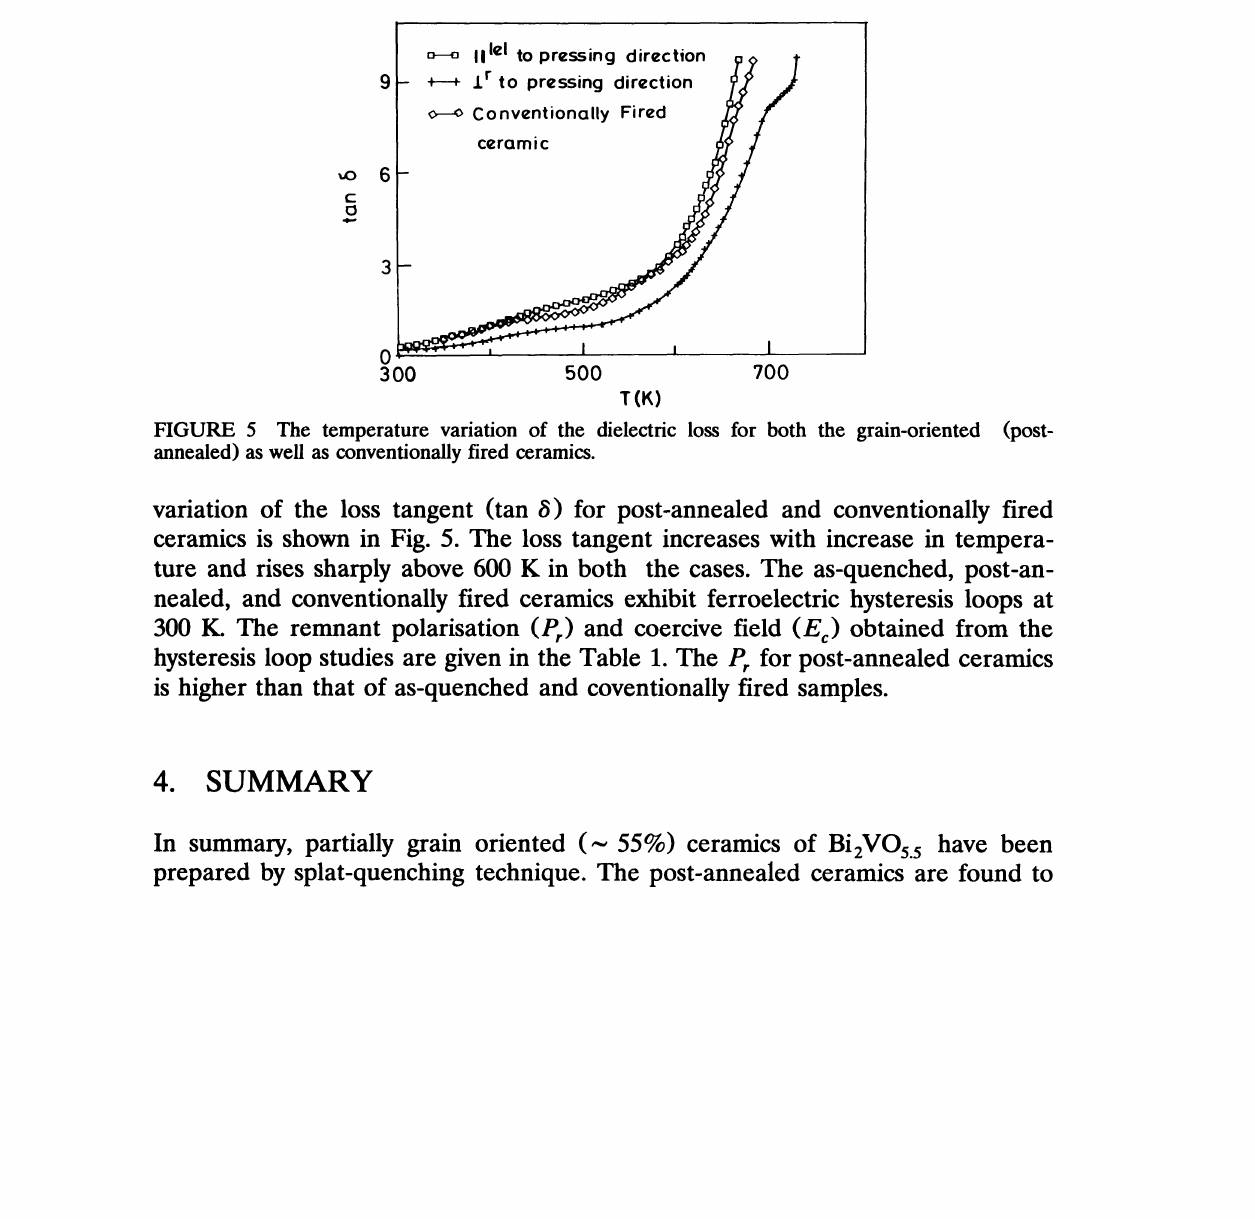
FIGURE 4 The temperature variation of the dielectric constant for both the grain-oriented (post- annealed) as well as conventionally fired ceramics.